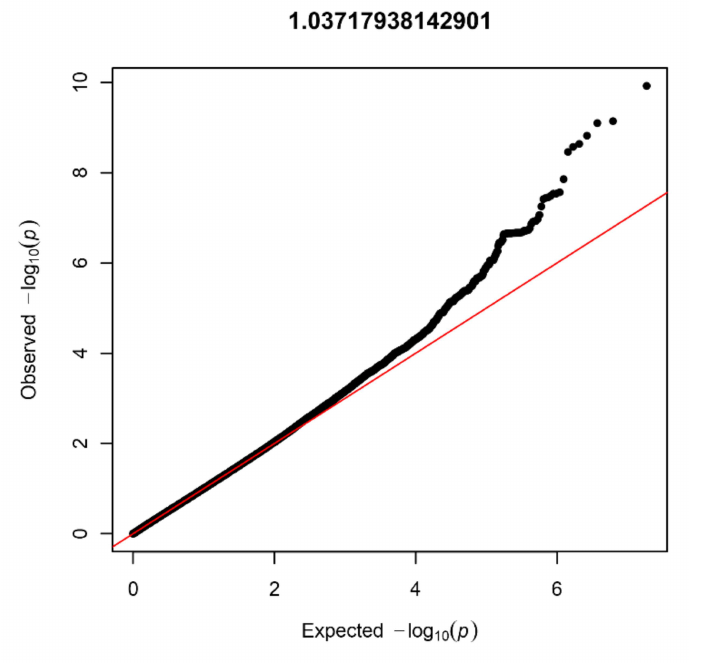
Figure 4. Quantile-quantile plot with lambda value for the NBS dataset (403 patients and 4366 controls).